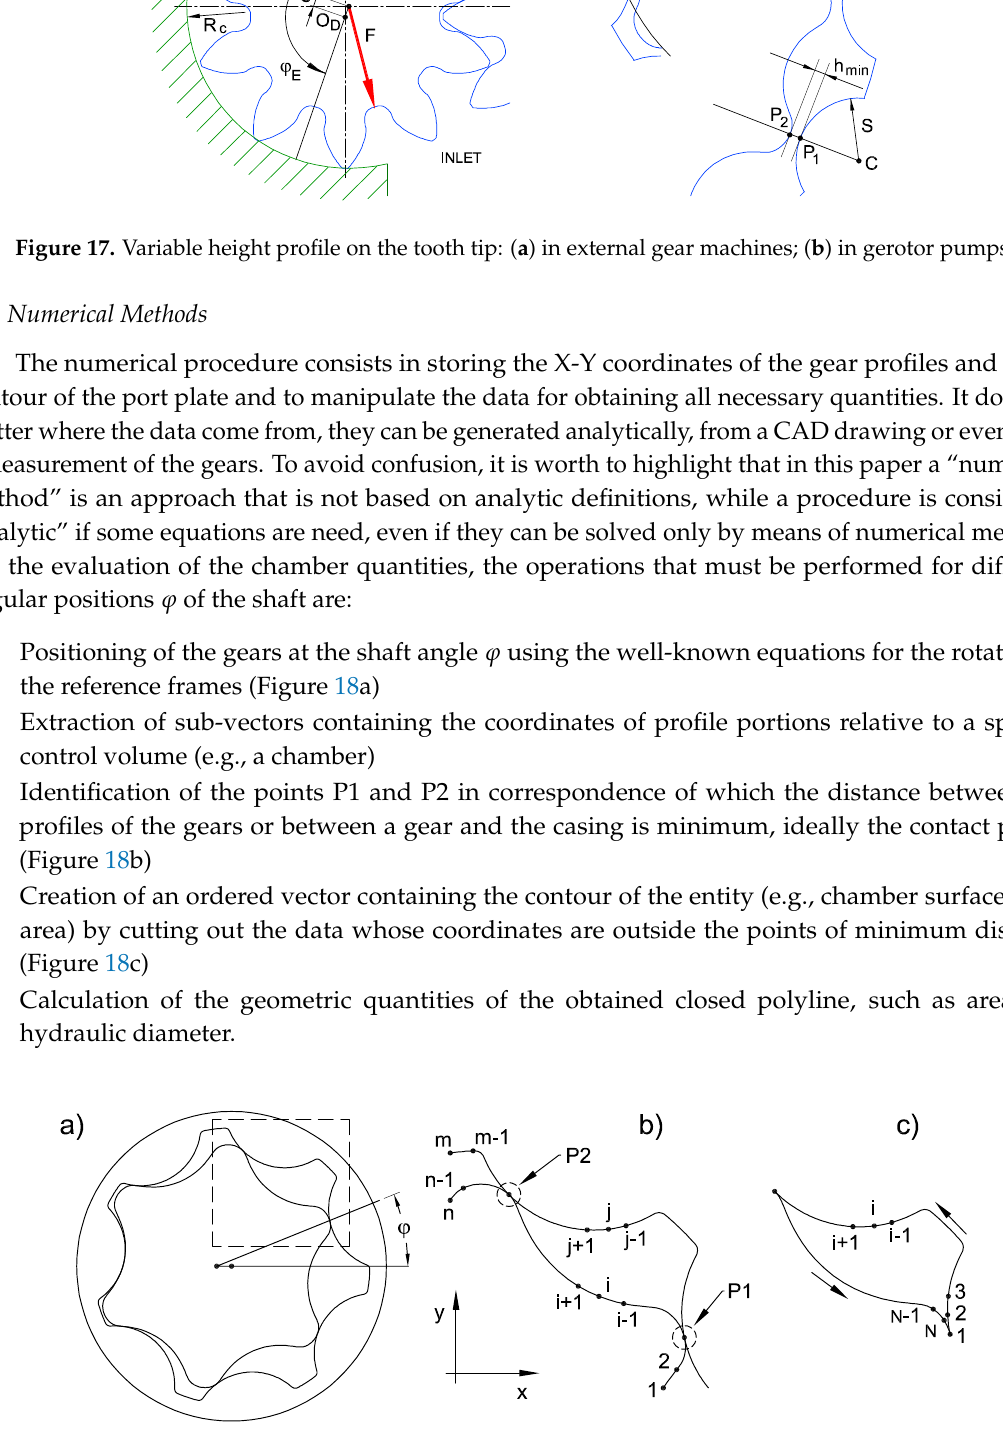
Figure 18. Steps for the generation of the chamber contour in a gerotor machine; ( a ) positioning of the gears; ( b ) identification of the contact points; ( c ) creation of a closed polyline.